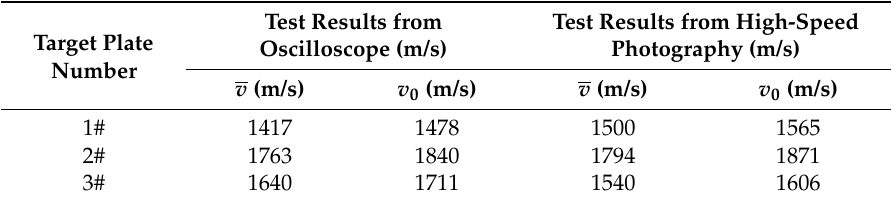
Table 6. Fragment velocity corresponding to the D-90 ◦ experiment.